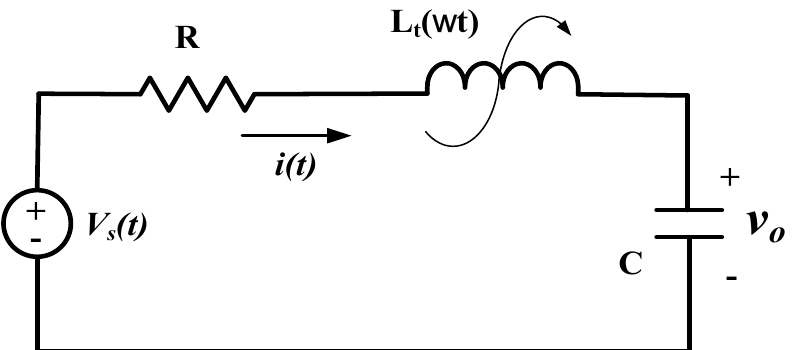
Figure 2. A modeling circuit for induction/synchronous